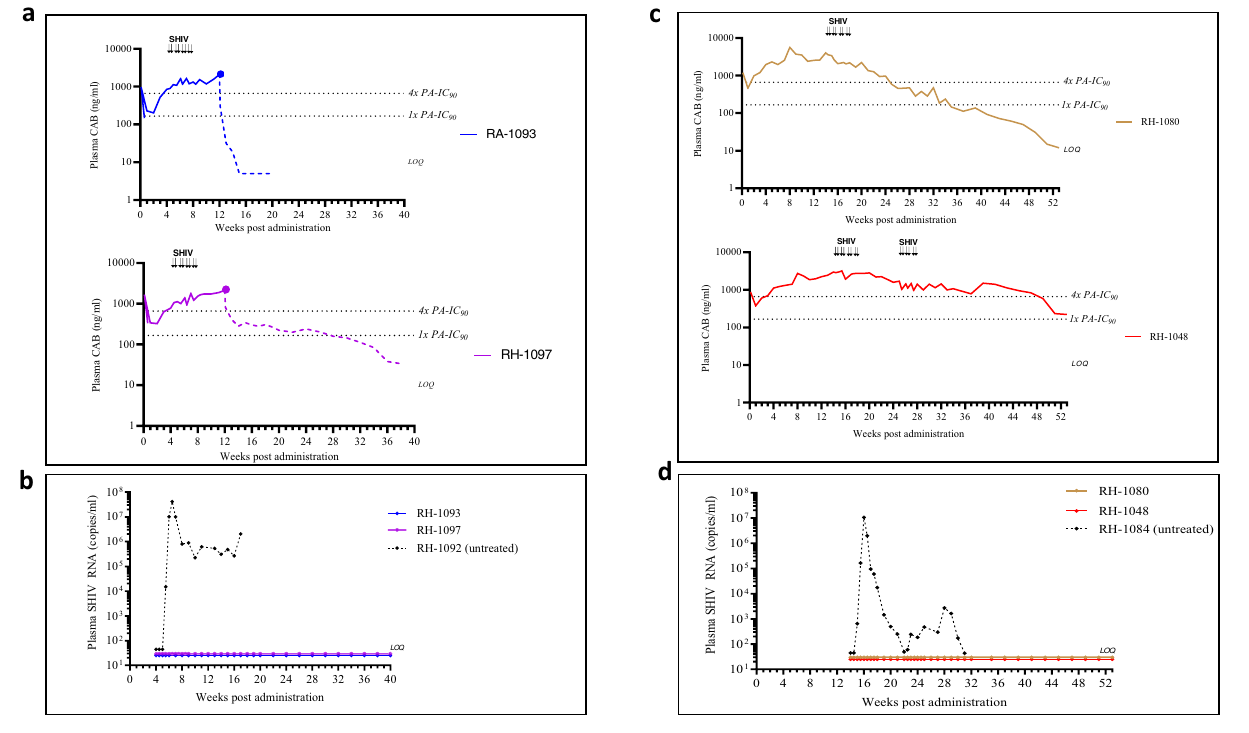
implantation from treated animals RH-1093, RH-1097, RH-42012 ( n =3) and an untreated control ( n =1). All scale bars represent 1mm (H&E, original magni fi cation ×4).